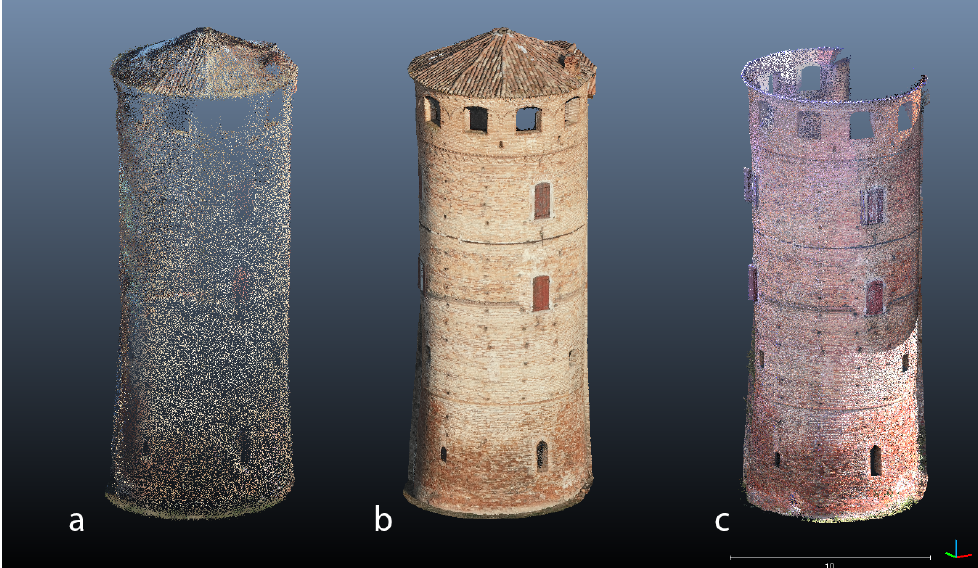
Figure 9. Point clouds of the entrance tower examined (1-pixel point dimension): ( a ) LiDAR L1; ( b ) P1 sensor and photogrammetric process; ( c ) Trimble SX10 data.